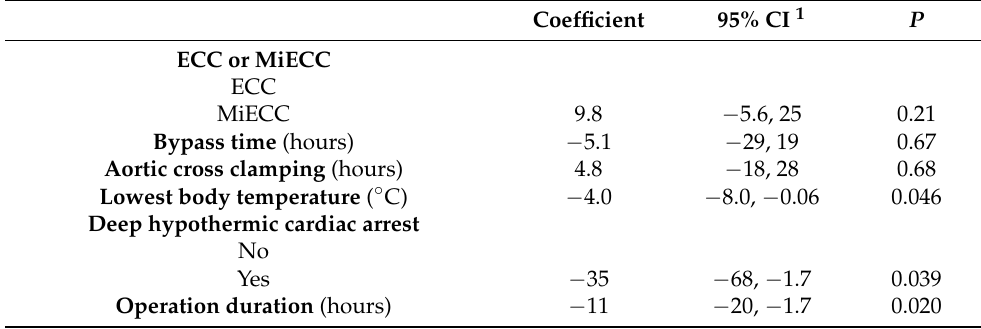
Table 4. Multivariable linear regression of the ratio of postoperative Lp(a) values to preoperative Lp(a) values (%) relative to several surgical characteristics. Note that Lp(a) values below the measurement accuracy (<2 mg/dL) were excluded from the